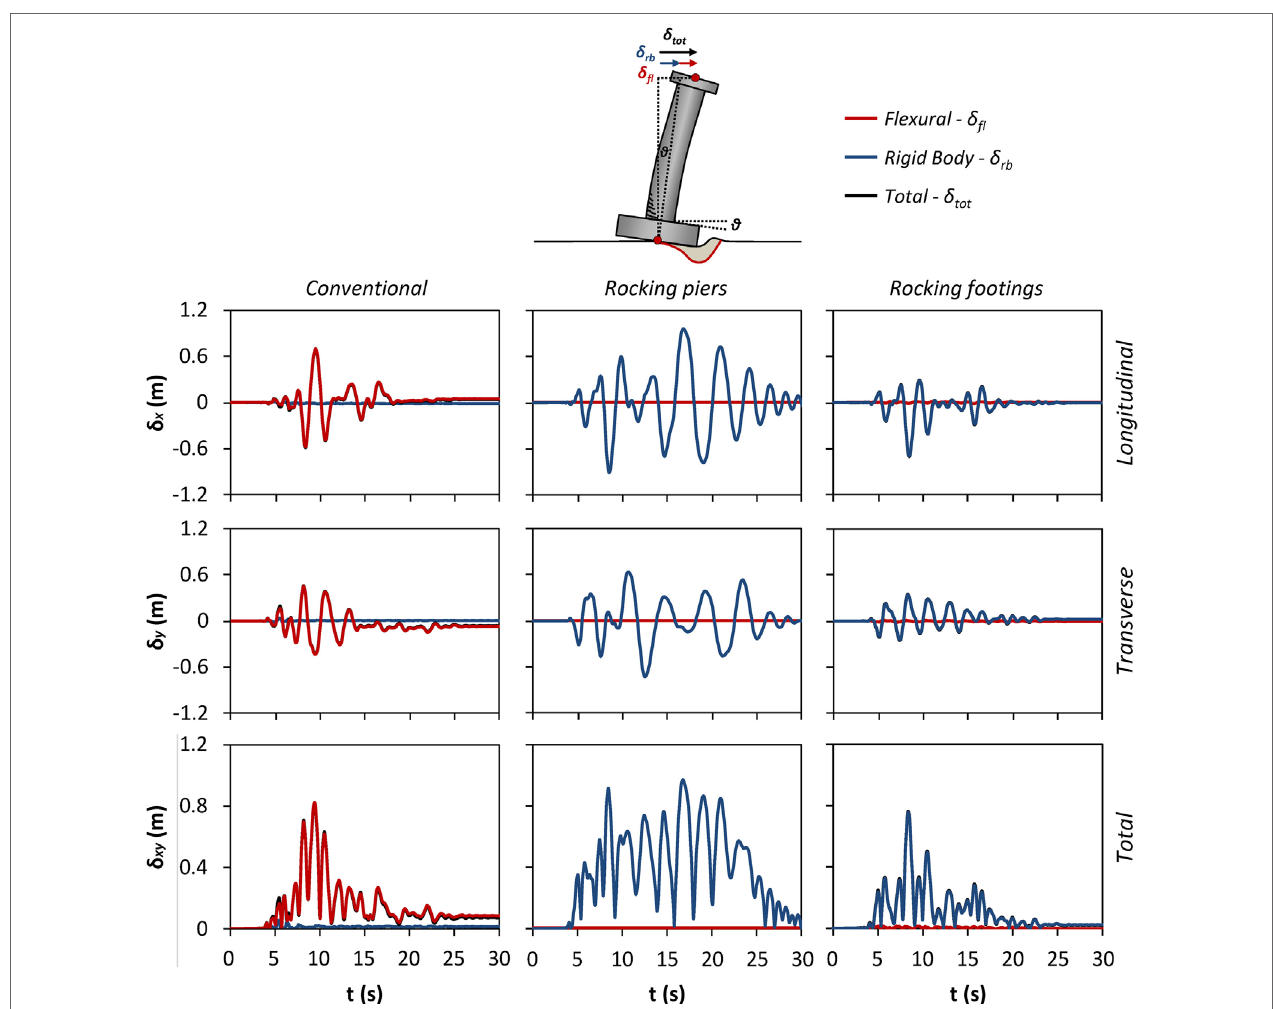
FigUre 10 | Comparison of the three design alternatives in terms of flexural—rigid body pier drift at each direction, and total pier drift time histories δ ( t ) indicatively for pier P4 for the Takatori